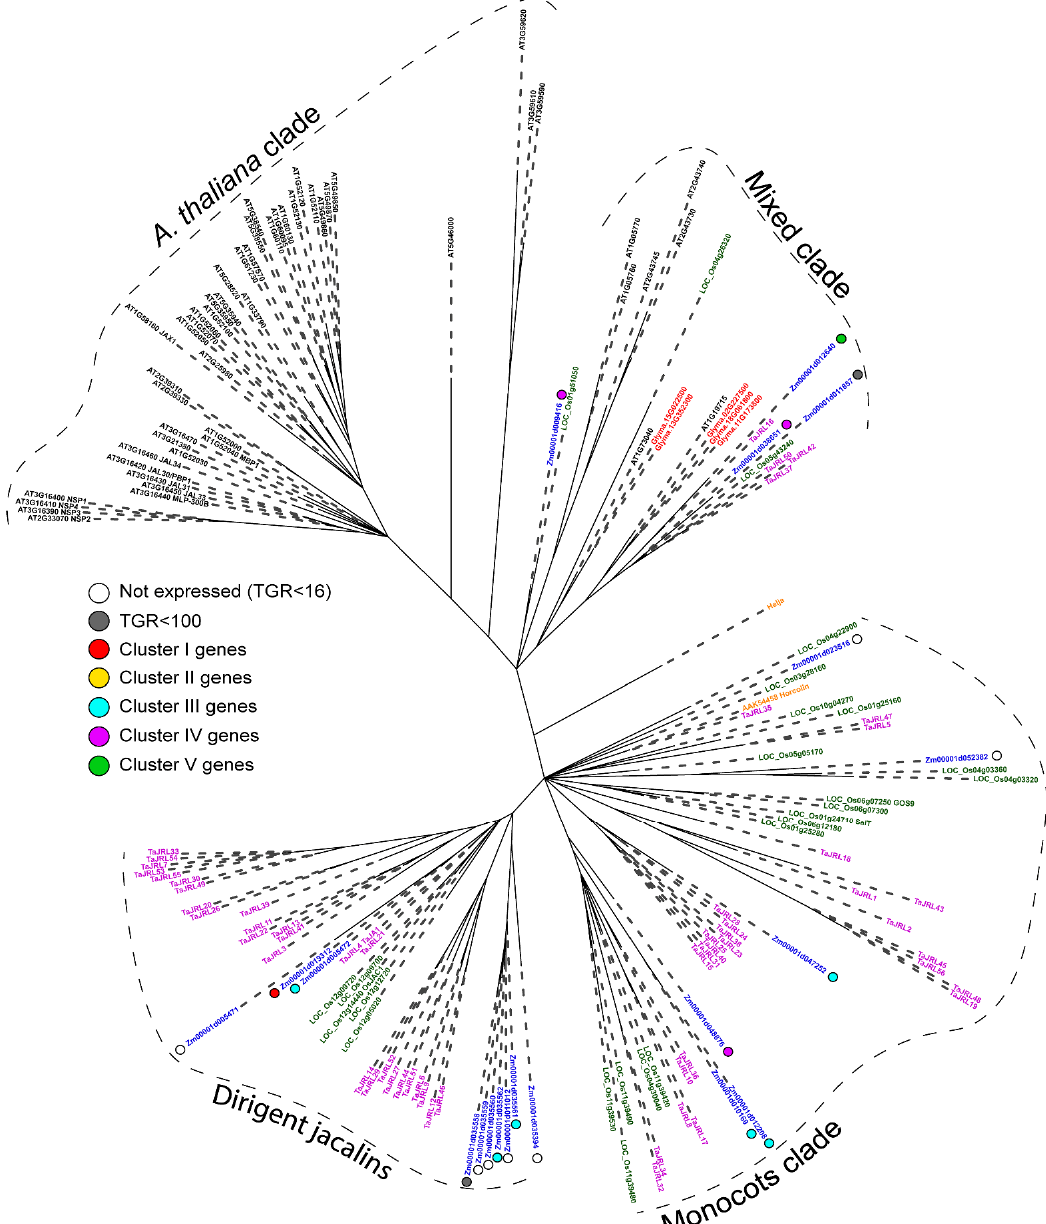
Figure 5. Phylogenetic dendrogram of jacalin-related (PF01419) lectin family members of A. thaliana (gene names are given in black font), Z. mays (blue font), G. max (red font) and T. aestivum (purple font). Sequences of two characterized jacalin-related lectins were added for comparison: Helja (from Helianthus annuus ) and Horcolin (from Hordeum vulgare ) (UniProtKB P82953) [32]. The colored dots next to Z. mays genes denote the character of expression: white—genes with no expression (TGR value less than 16 in all samples); gray—genes with a TGR value less than 100 in all samples; red—genes from cluster I, expression decreased from meristem and root cap zones to late elongation; yellow— genes from cluster II, expression peaks in the early elongation zone; blue—genes from cluster III, high expression from early to late elongation; purple—genes from cluster IV, expression increased in the root cap and also increased from meristem zone to late elongation; green—genes from cluster V, highest expression in the late elongation zone. Only branches with ultrafast bootstrap support values greater than 80 are